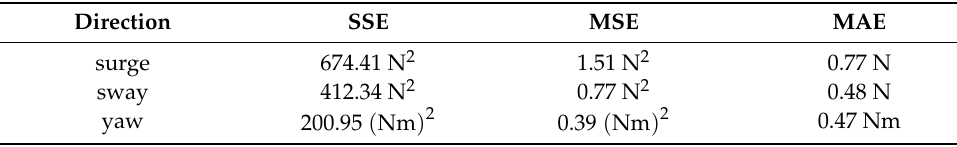
Table 3. Predicting error of artificial neural network.